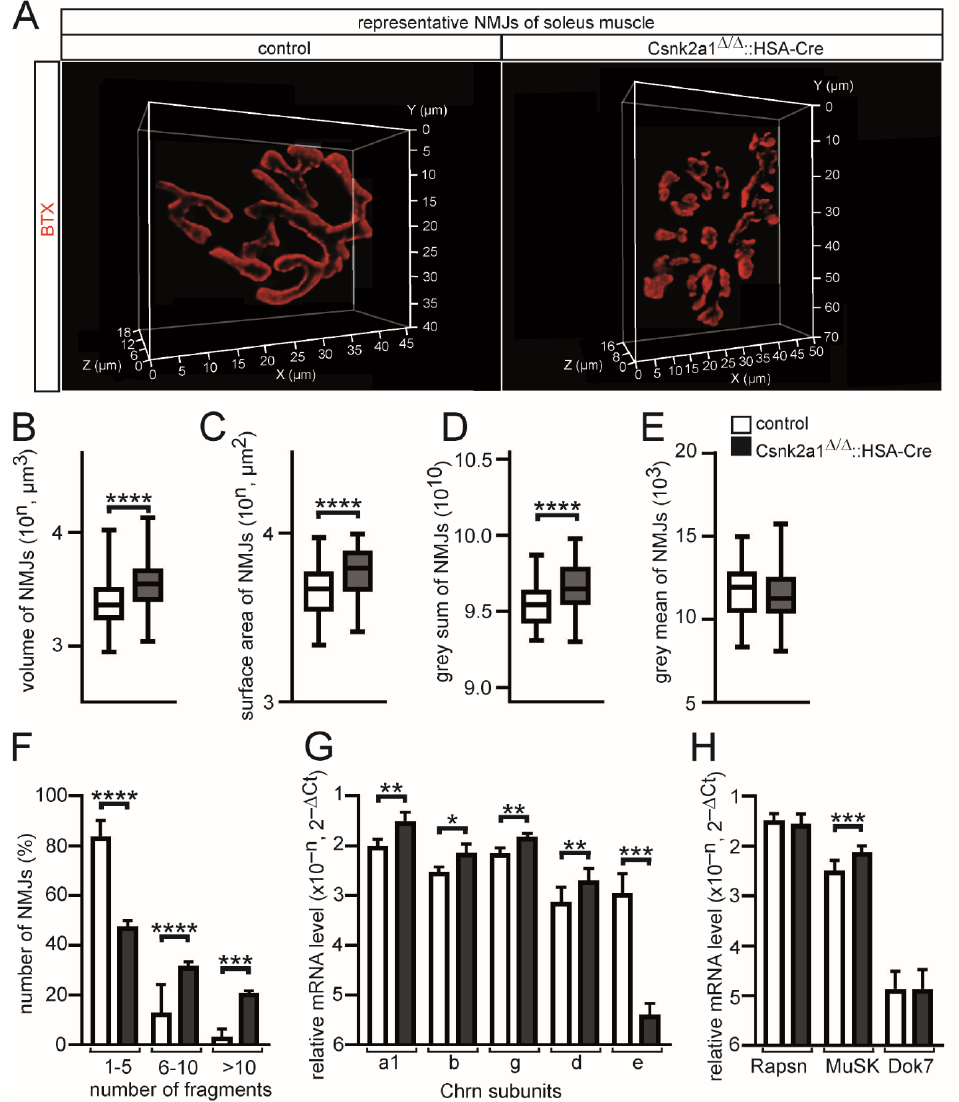
Figure 4. NMJs of conditional Csnk2a1 knockout mice are heavily fragmented and accompanied by modulated synaptic expression of all Chrn transcripts and receptor tyrosine kinase MuSK. ( A ) Typical 3D images from an individual NMJ of a control and a conditional Csnk2a1 knockout soleus muscle fiber are presented. ( B – E ) Graphs summarize quantitative 3D imaging parameters of NMJs of soleus muscle fibers of conditional Csnk2a1 knockout mice in comparison with controls. Note, NMJ volume, surface area, and grey sum are increased in conditional Csnk2a1 knockout mice. ( F ) NMJ fragmentation grade is presented by a graph subgrouping three different ranges of NMJ fragment numbers. ( G , H ) Total RNA was extracted, 1st cDNA generated, and qPCR experiment performed. Graphs summarize changes in transcription levels of myogenic and synaptic genes as indi- cated. Note, Chrne is significantly downregulated, while all other Chrn genes and Musk are upregulated in conditional Csnk2a1 knockout hindlimb muscles. All labeling of graph bars represents the genotype of mice as indicated in ( E) . Data are represented as mean ± S.D.; n ≥ 5 mice per genotype and analysis of >150 individual NMJs per muscle. **** p < 0.0001, *** p < 0.001, ** p < 0.01, * p < 0.05.